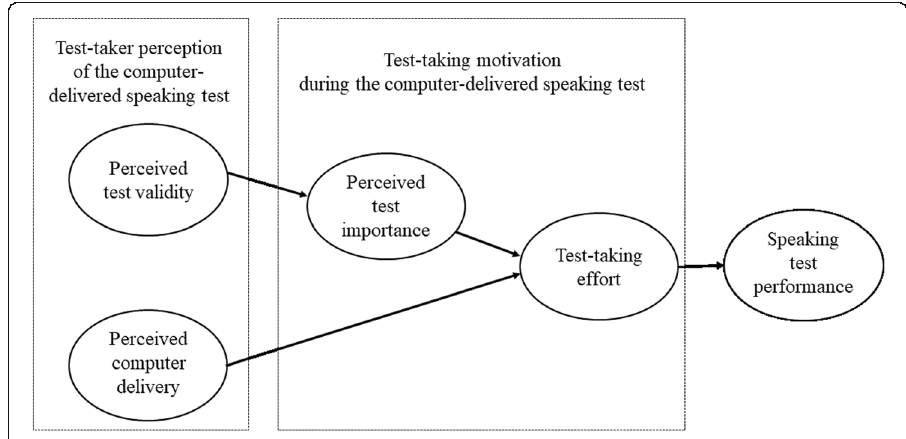
Fig. 1 Proposed relationships between test-taker perception, test-taking motivation, and test performance. It is proposed that perceived test validity influences test-taking effort indirectly through the mediation of perceived test importance. Unfavorable perception of computer delivery will lead to decreased test-taking effort, which in turn affects test